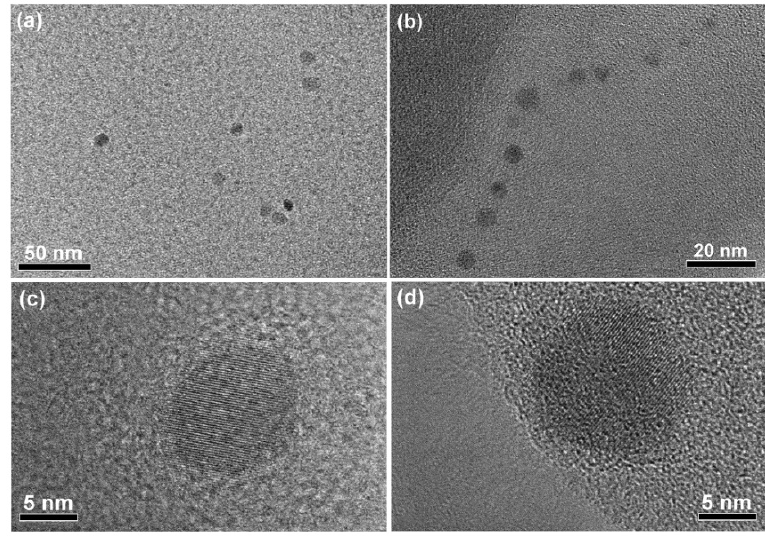
Figure 2. TEM ( a , b ) and HRTEM ( c , d ) images of the CNDs derived from β –Lactoglobulin (LG) protein.